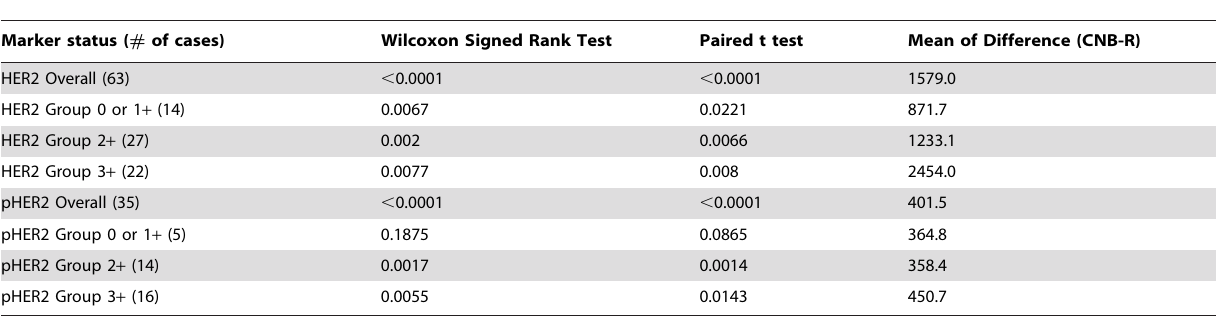
Table 3. HER2 and pTyr 1248 HER2 AQUA score comparisons between CNBs and